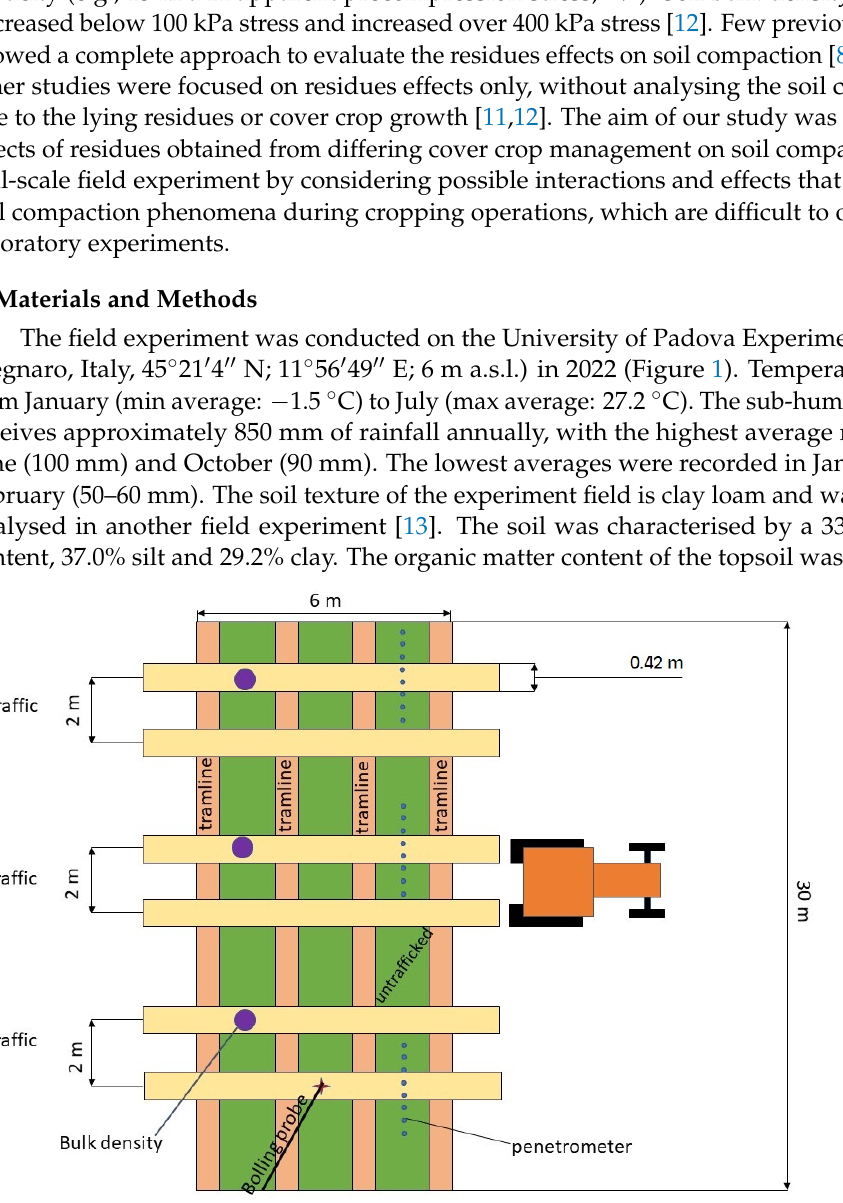
Figure 1. Traffic pattern of the experimental field test for every covering plot. The picture shows how the traffic was managed during the experiment to avoid compaction on the sampling zone through the sampling area of the bulk density, penetrometer to measure cone index and Bolling probe to assess mean normal stress. A total of 16 covering plots were used with 4 different covering treatments and 4 replicates.